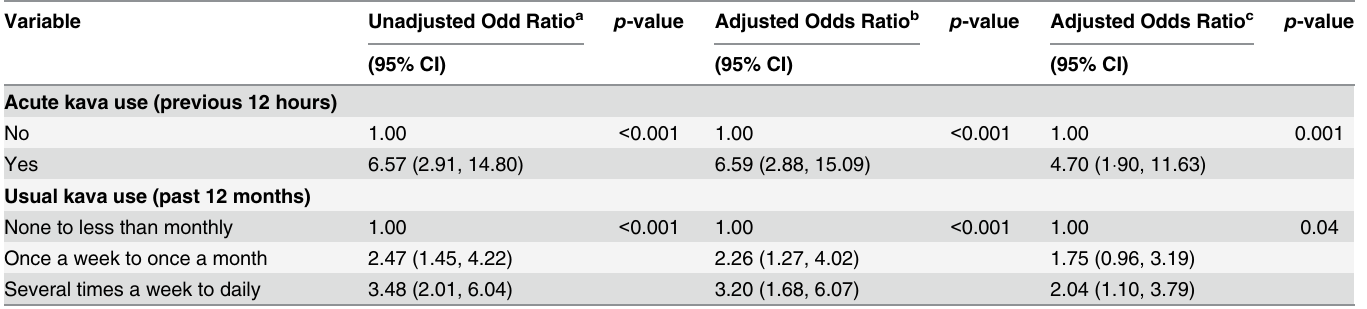
Table 2. Association of self-reported kava use with risk of car crash resulting in injury, Fiji, 2006.